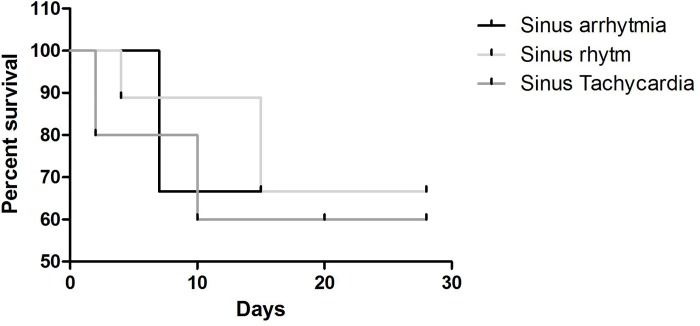
Survival analysis chart according to the base rhythm observed in the conventional ECG examination for the sick group (G1).